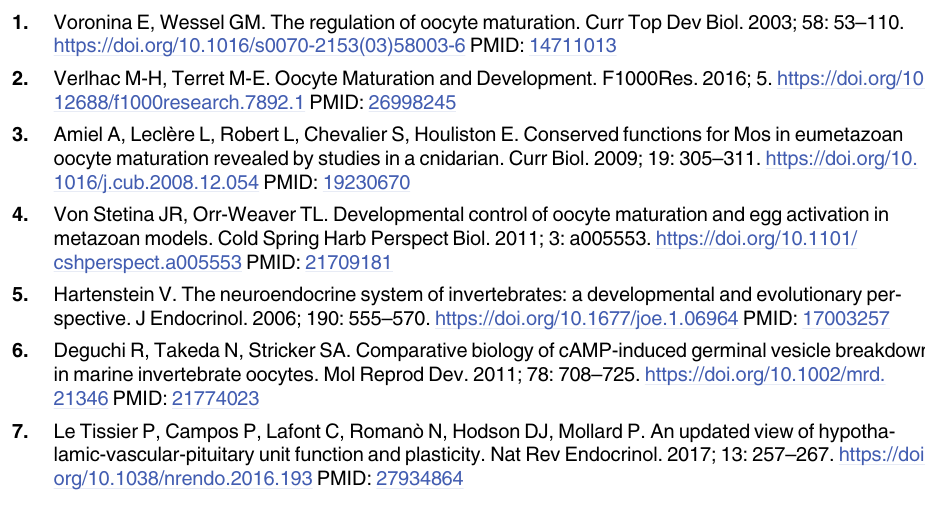
S5 Data. Numerical data corresponding to S1 Fig. Normalized counts in the different sequenced samples for each GPCR candidate. GPCR, G protein–coupled